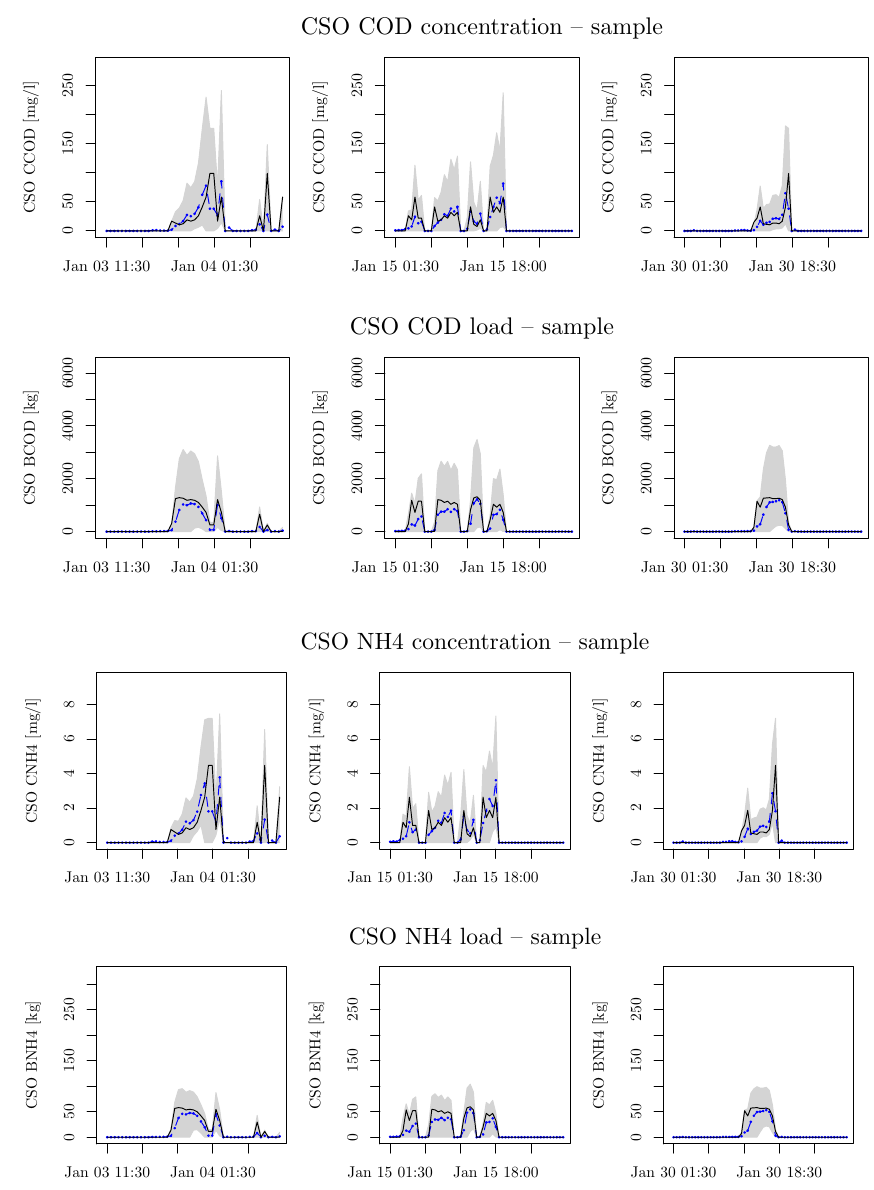
Figure 4. Time series for chemical oxygen demand (COD) load and concentration in spill water volume in the combined sewer overflow (CSO) and ammonium (NH 4 ) load concentration in spill water volume in the CSO at 30-min time step for simulation and analysis of Monte Carlo simulation. Deterministic simulation (continuous black line), mean (dotted blue line), and 95% prediction band (grey band) of the Monte Carlo